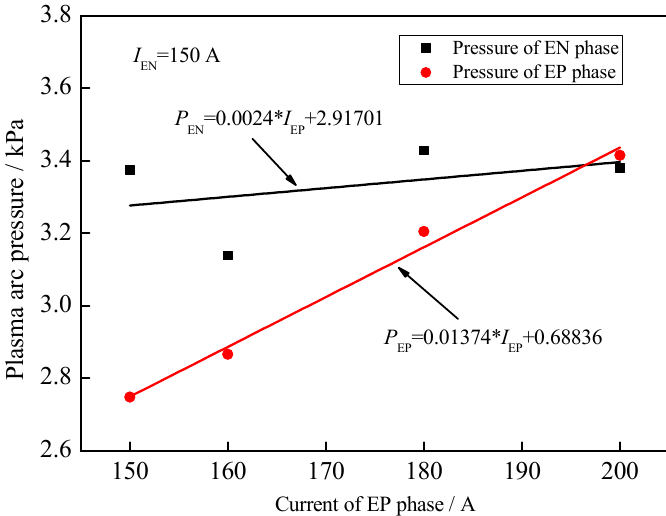
Figure 17. Average plasma arc pressure at different EP currents.